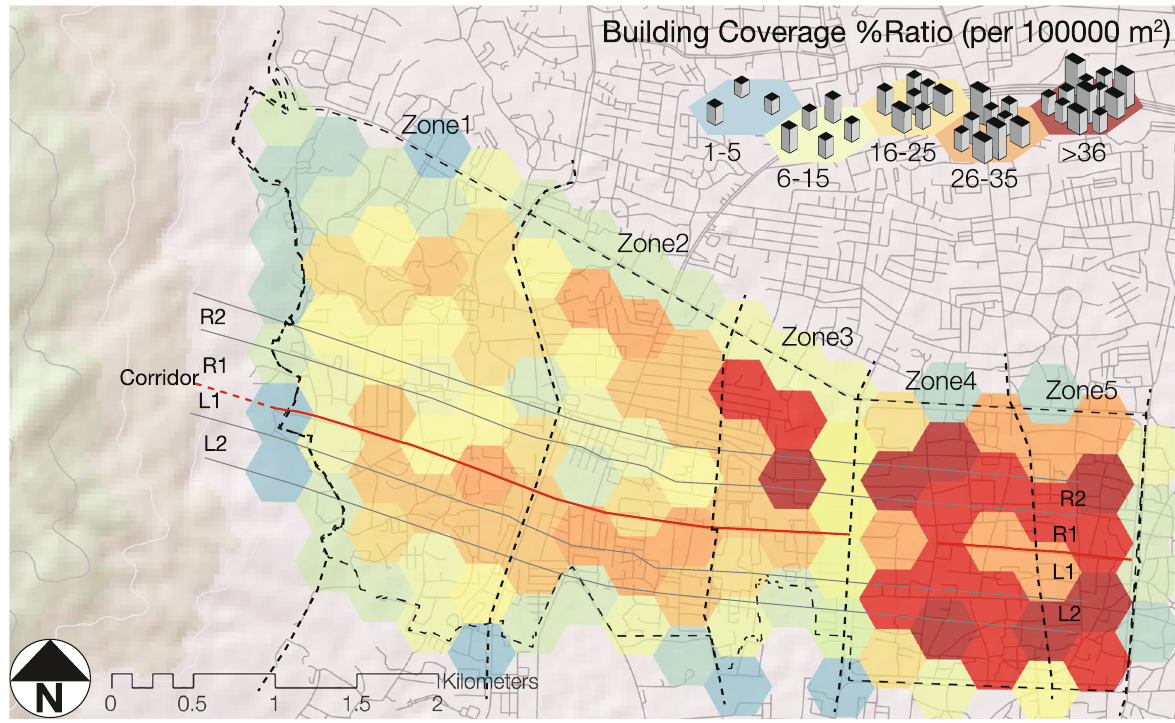
Fig. 9 Building coverage ratio in five zone (Source: the authors)